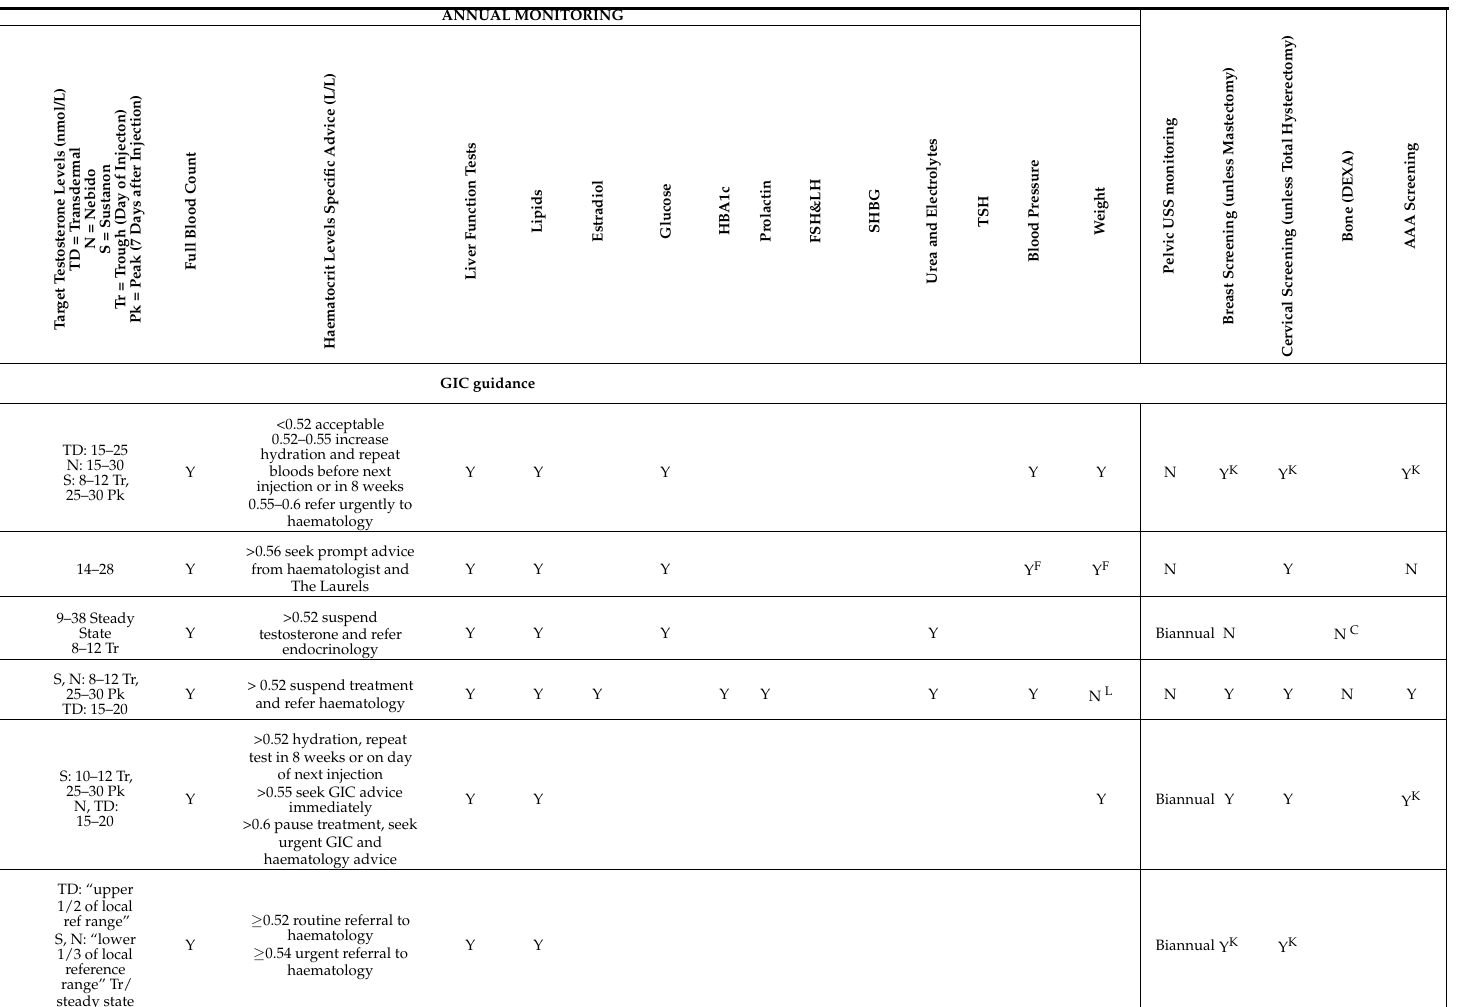
Table 1. Cont. Table 2. Comparison of national, international, and patient specific prescribing and monitoring guidelines for trans women (observed males at birth) with gender